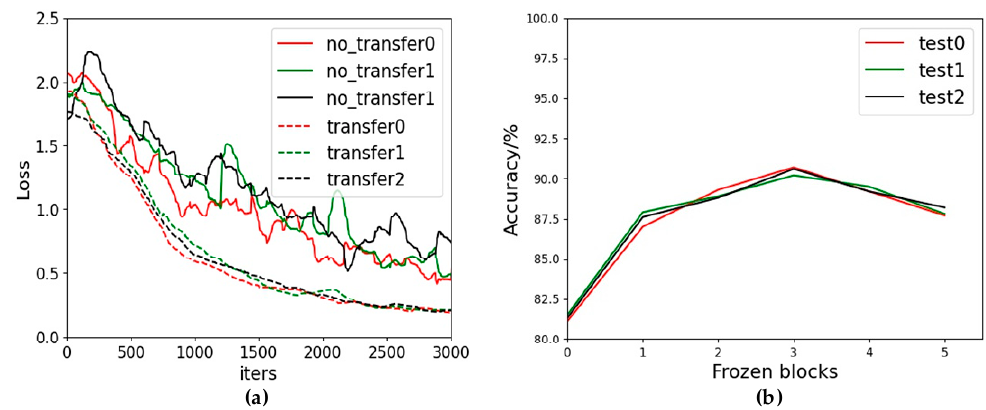
Figure 11. Changes of loss and accuracy in transfer learning: ( a ) Comparison of the loss of using transfer learning and no transfer learning in three sub-tests; ( b ) comparison of the accuracy of freezing different convolutional blocks in three sub-tests.